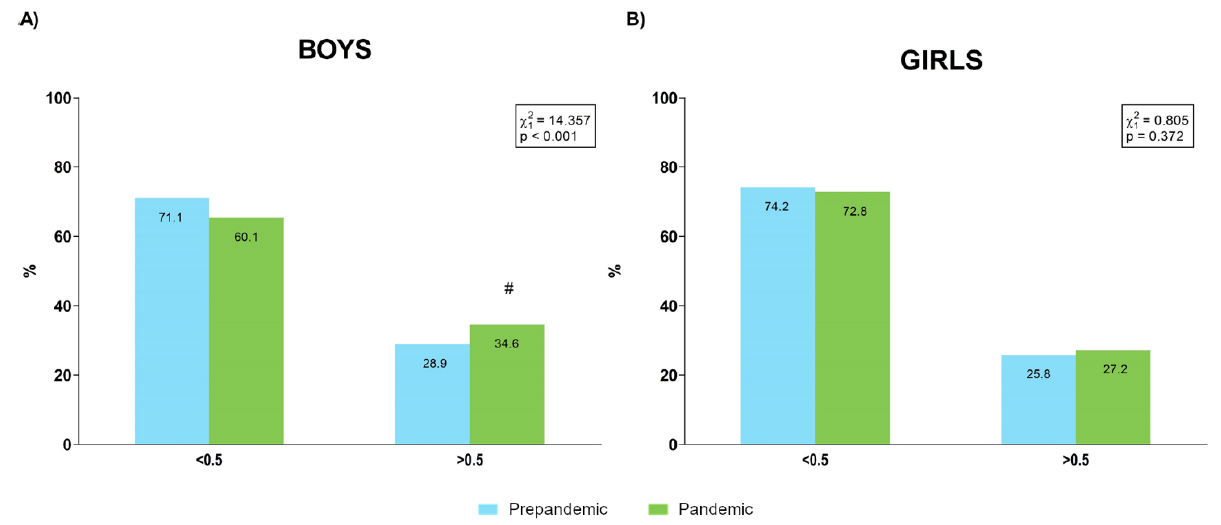
Figure 6. Percentage of boys ( A ) and girls ( B ) over and under the 0.5 cut point for waist to height ratio (WHtR) before and during the pandemic. #: absolute value of the standardized residual ≥ 2 for this category.